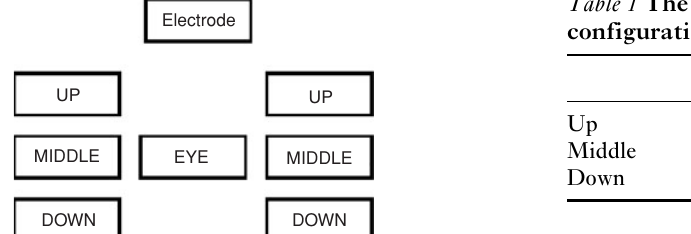
Figure 18 Failure detection and recovery.